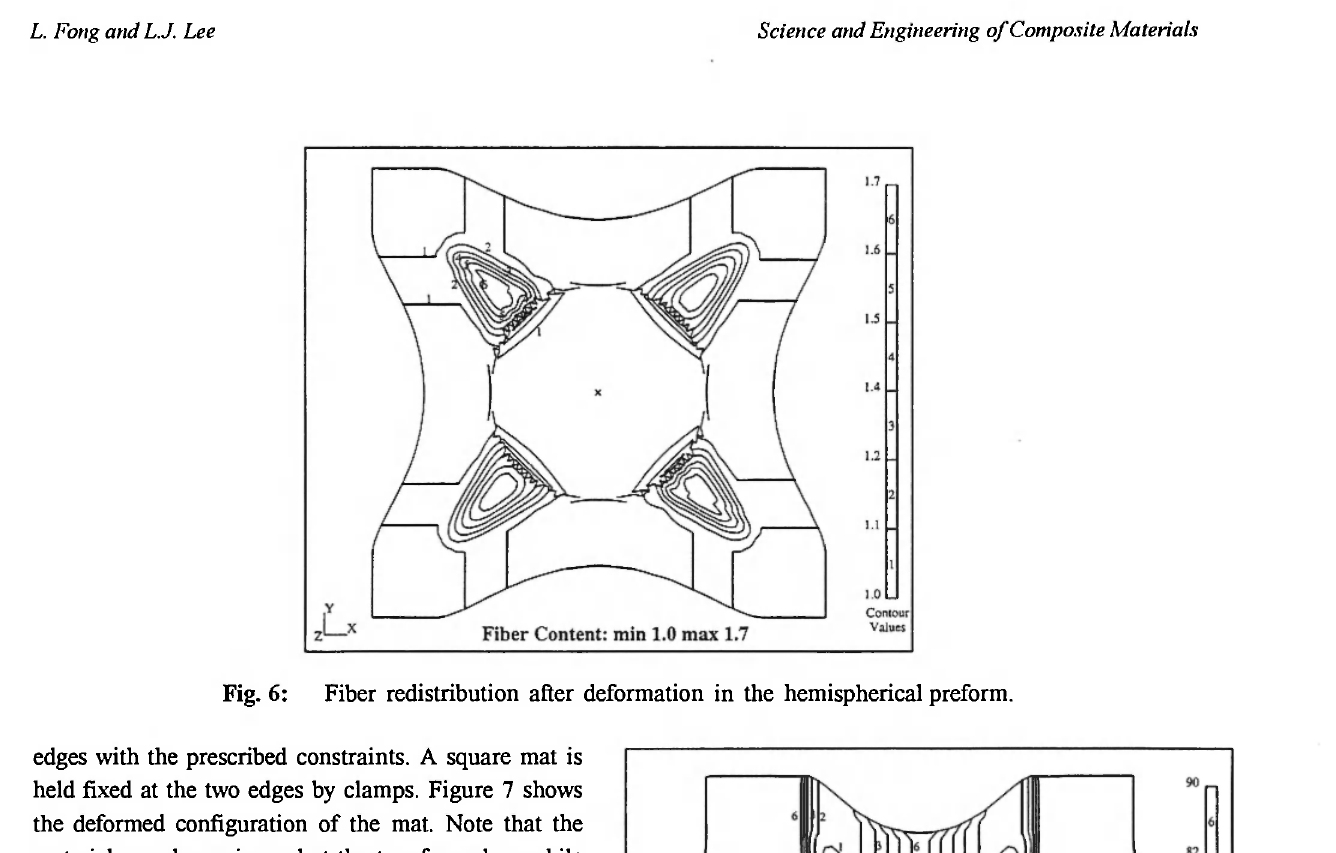
Fig. 8: Shear angle distribution with clamped edges. changed from 33° to 40°, which means the second case is less likely to form wrinkles if both use the same mats. Figure 9 is the contour plot of the fiber content distribution after deformation for the case with edge clamping. The range of the numerical value of the fiber content changed from 1.0-1.7 to 0.8-1.4 compared to the case without edge clamping. This implies that edge clamping in the fiber mat preforming process may